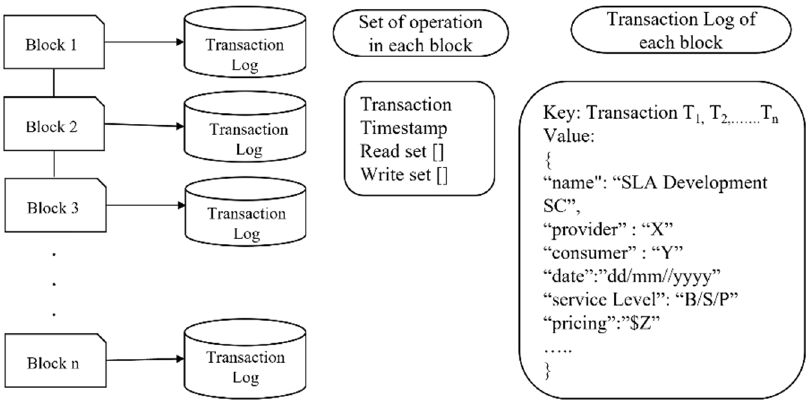
Figure 2. The transactions log is monitored to check vulnerabilities.